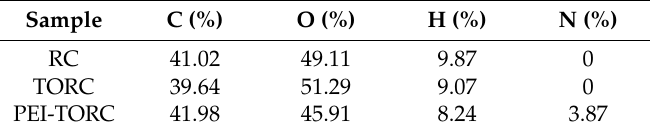
Table 1. Elements analysis results of unmodified and modified cellulose membranes. Sample C (%) O (%) H (%) N (%) RC 41.02 49.11 9.87 0 TORC 39.64 51.29 9.07 0 PEI-TORC 41.98 45.91 8.24 3.87